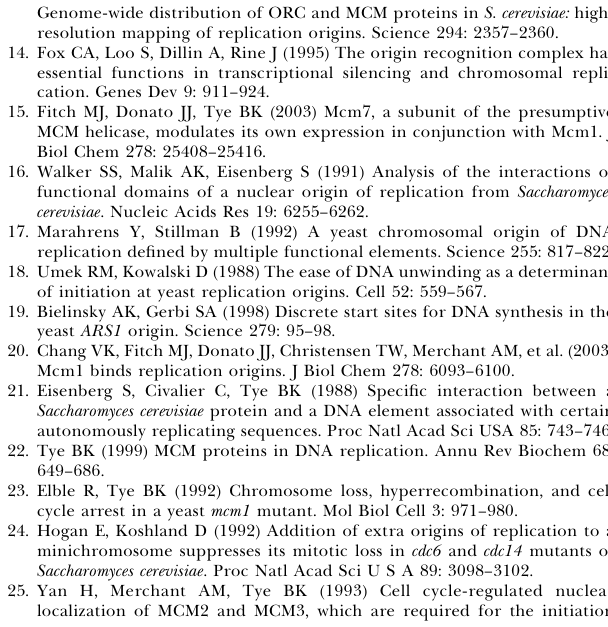
Sites of colocalization of replication initiation proteins such as ORC and MCM proteins have been used as indicators of replication origins in a genome-wide study [13]. Systematic names were assigned to putative replication origins based on their positions along a particular chromosome [13]. Novel ARSs were given a systematic name to reflect their locations in the genome with respect to the locations of the published putative replication origins. Strain refers to strain from which plasmid was isolated. Cloned indicates ARS was subcloned or recloned by PCR for further